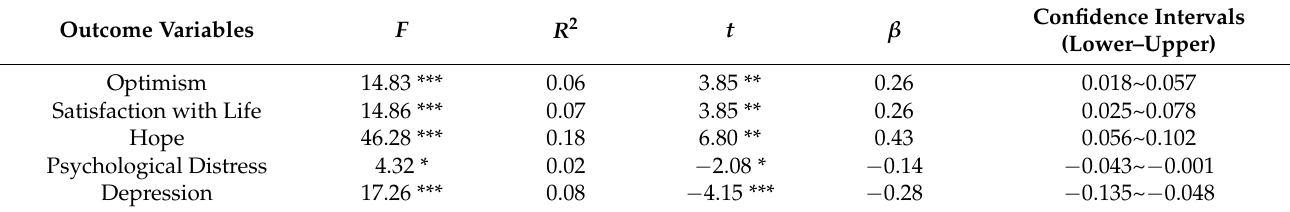
Table 5. Results of regression analyses with emotional intelligence as predictor variable (study 1). Outcome Variables